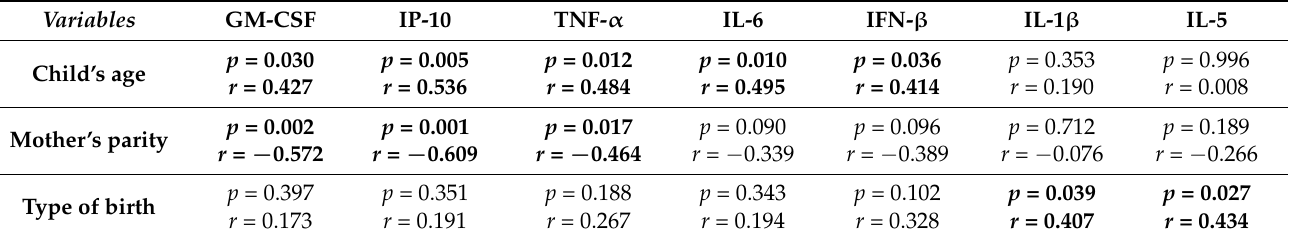
Table 5. p and r correlation coefficients related to the statistically significant correlations recorded in the group of vaccinated